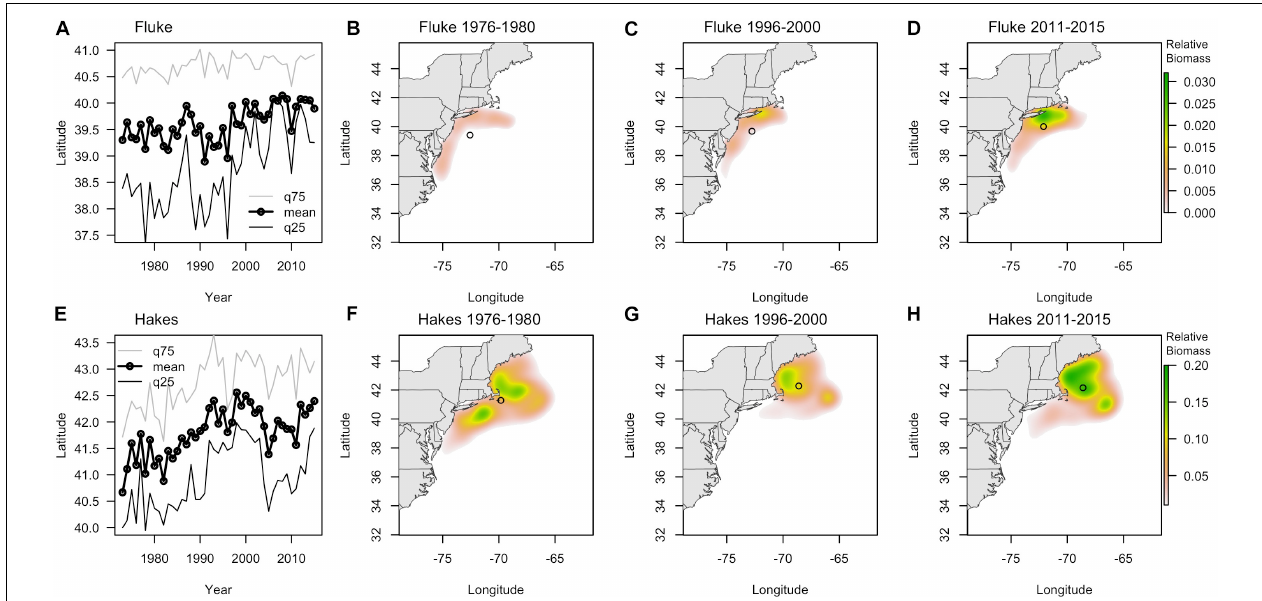
FIGURE 3 | (A,E) Latitudinal centroid of biomass in survey location (fall and spring combined) (labeled as mean, black line with dots) and the 25th (q25, dark gray line) and 75th quantile (q75, light gray line) for fluke (A) and combined red and silver hake (E) since 1970. (B–D) Kernel density of survey biomass for fluke